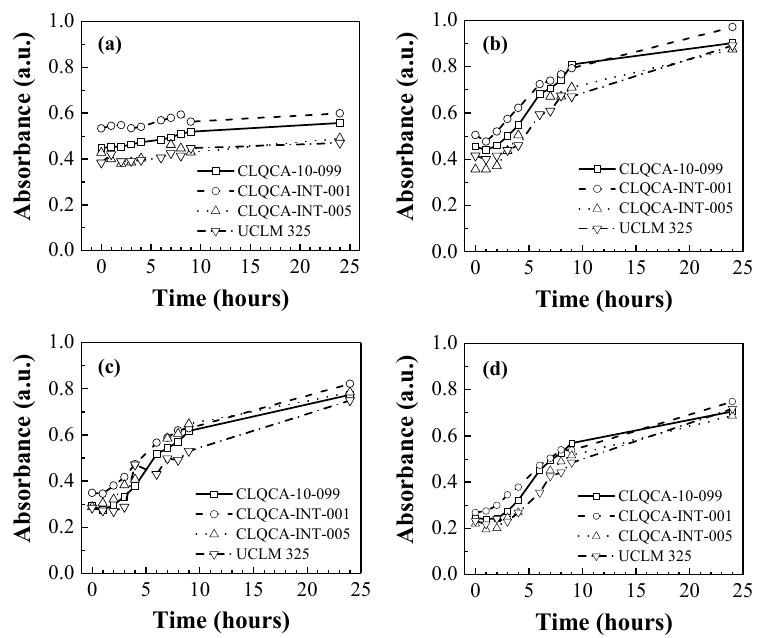
Figure 1. Growth curves of the di ff erent S. cerevisiae strains (CLQCA-INT-001, CLQCA-INT-005, CLQCA-10-099 and UCLM 325) at di ff erent nitrogen concentrations (yeast hydrolysate): ( a ) without nitrogen source, ( b ) 0.2 g N · L − 1 , ( c ) 0.3 g N · L − 1 , and ( d ) 0.4 g N · L − 1 . Plotted values correspond to average values across three replicates. Standard deviations were < 5.4% in all cases, and generally < 3% (error bars are not shown because of the small standard deviation values).